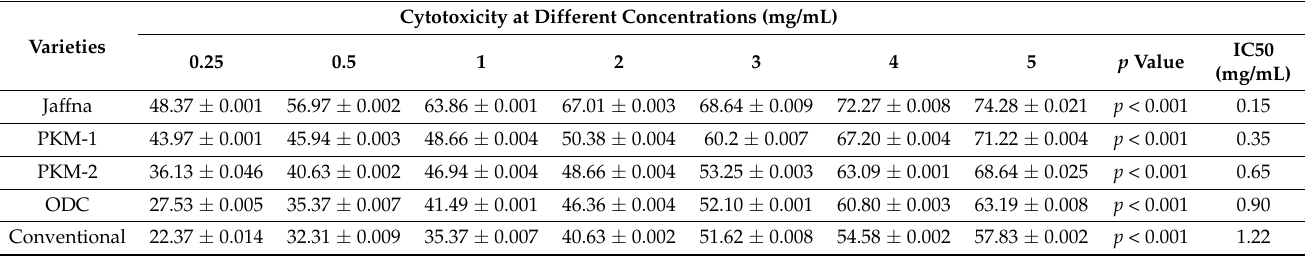
Table 3. MTT assay using MLEs of five varieties of Moringa oleifera